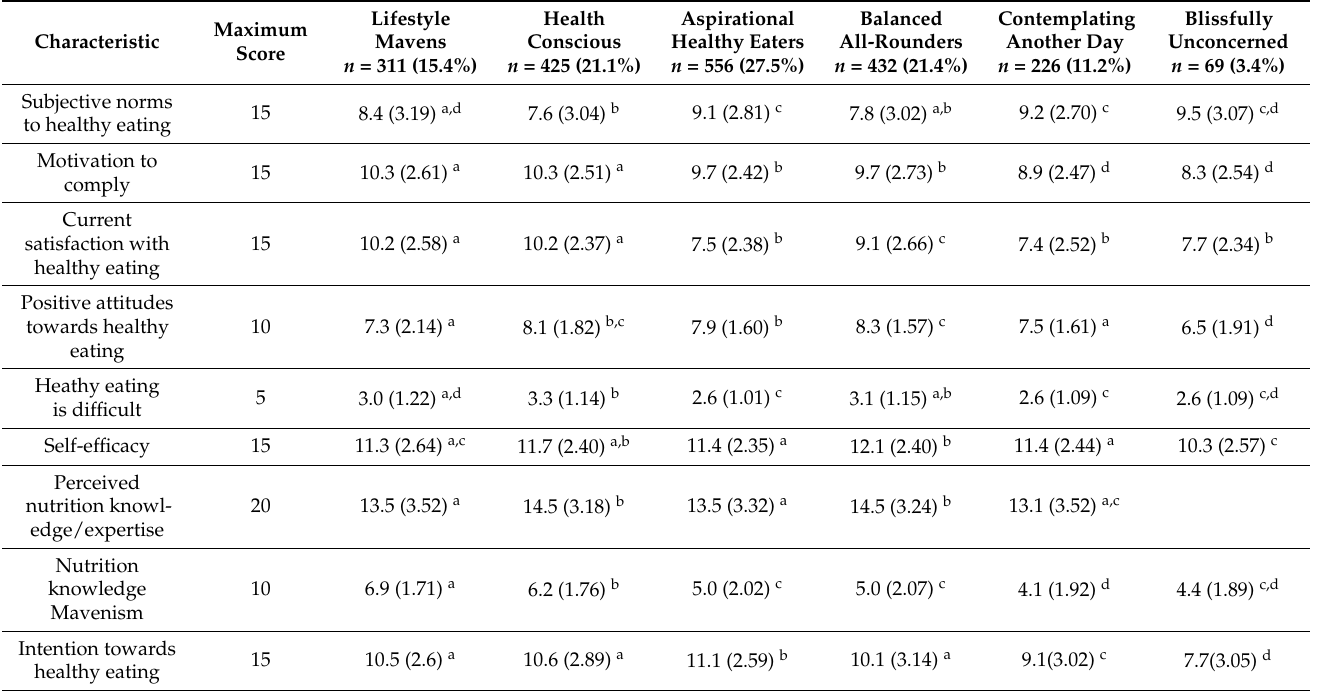
Table 4. Normative beliefs and motivation towards food and eating in the Living and Eating Health Segments (LEHS) ( n =